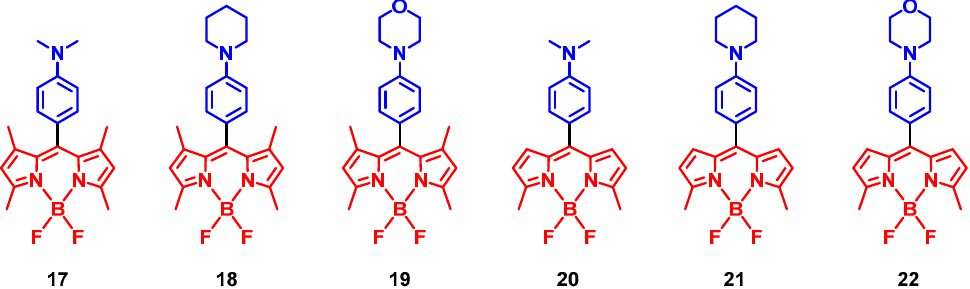
Figure 4. Phenothiazine-Bodipy dyads showing SOCT-ISC.